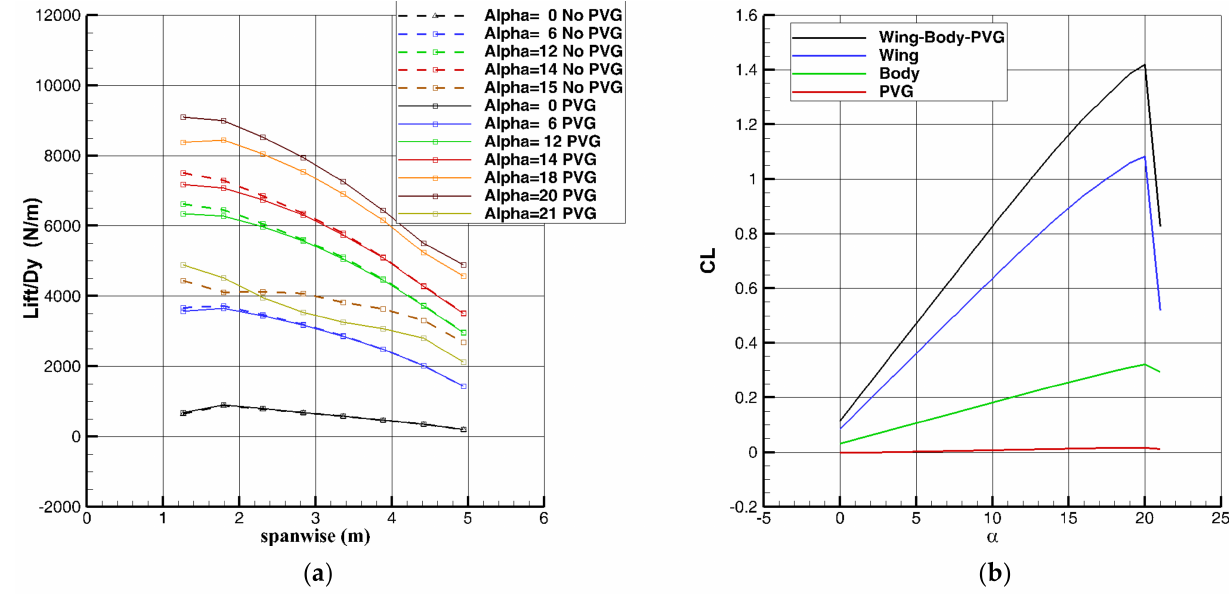
Figure 10. Effect of PVG on the clean configuration of the wing-body: ( a ) spanwise lift distribution; ( b ) component contribution in C L − α